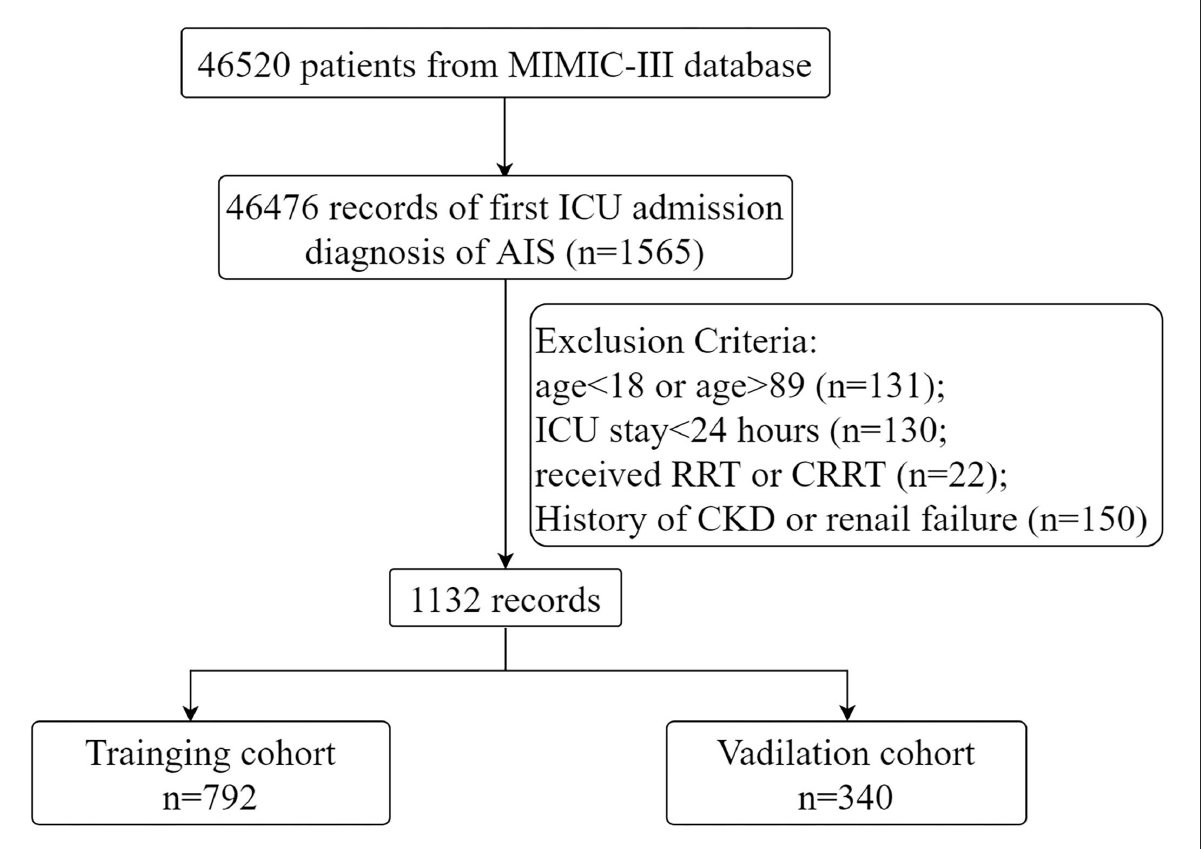
FIGURE1 The flowchart of the study.